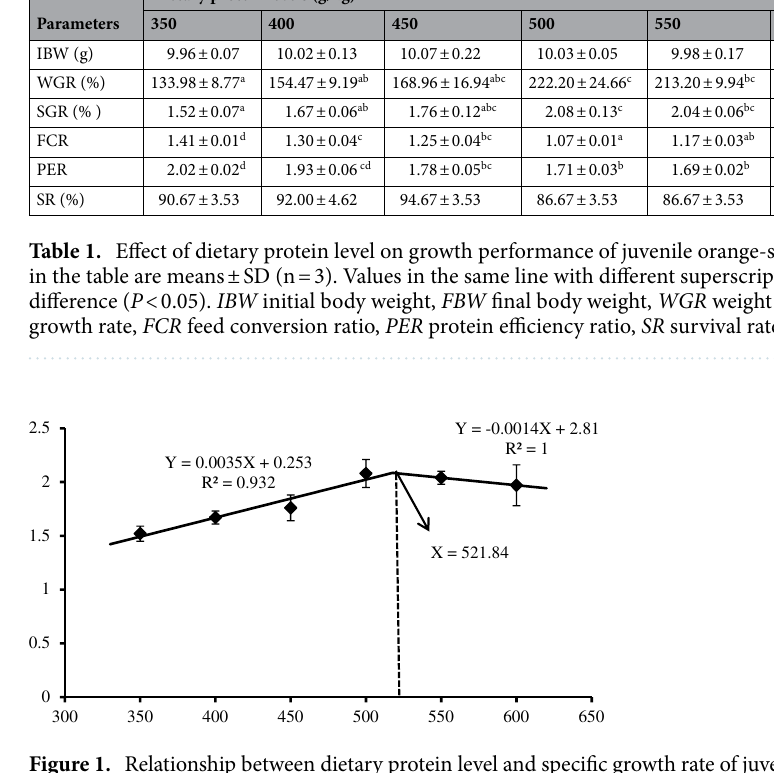
Figure 1. Relationship between dietary protein level and specific growth rate of juvenile orange-spotted grouper fed the experimental